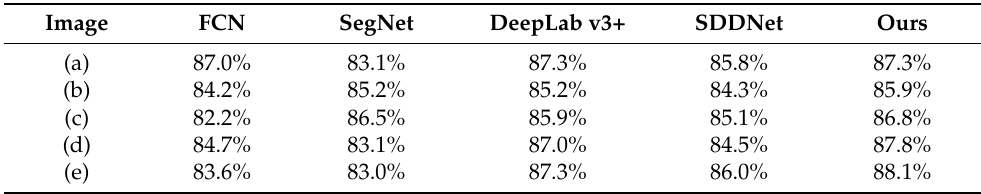
Table 2. Mean intersection over union